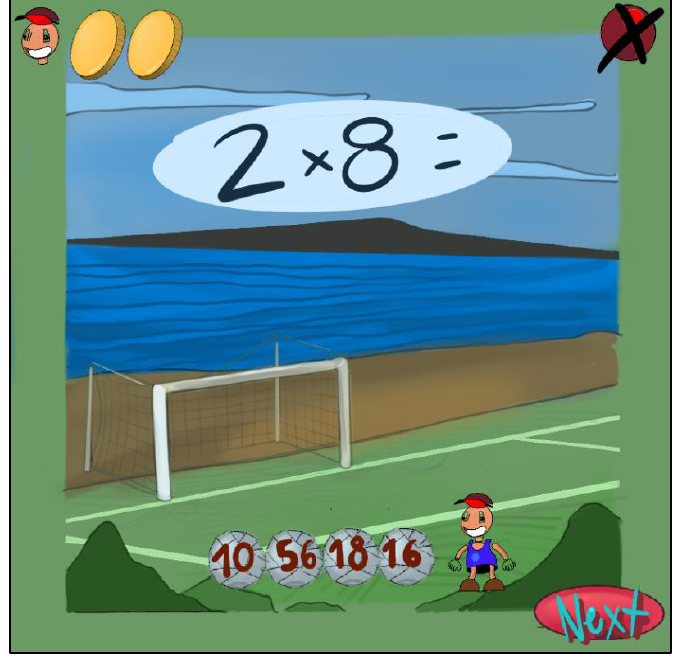
Figure 1. Right/wrong question in first scene.